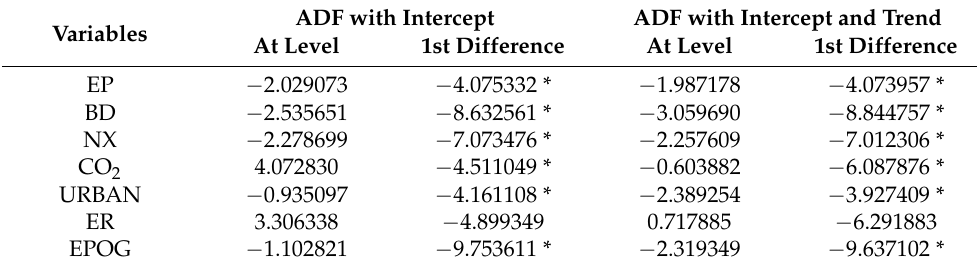
Table 4. Unit root